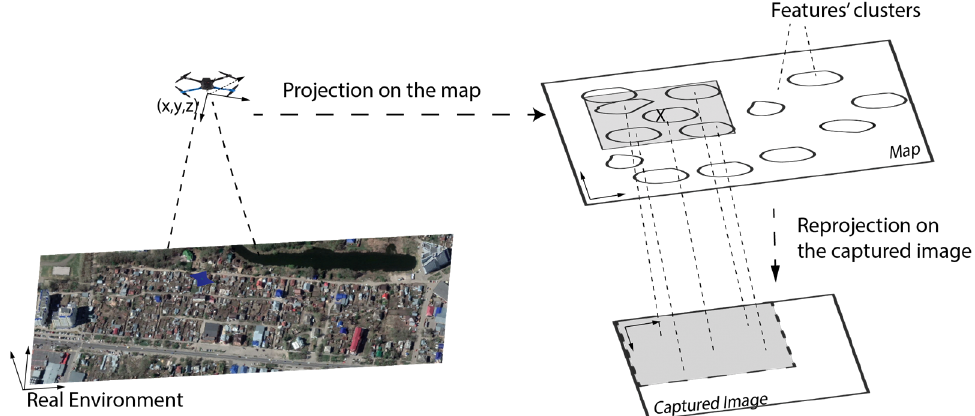
Figure 5. Reducing the matching space, both on the map and the captured image. The searching area on the map was predicted using INS measurements, then this area was projected on the captured image using the camera’s external and internal parameters.